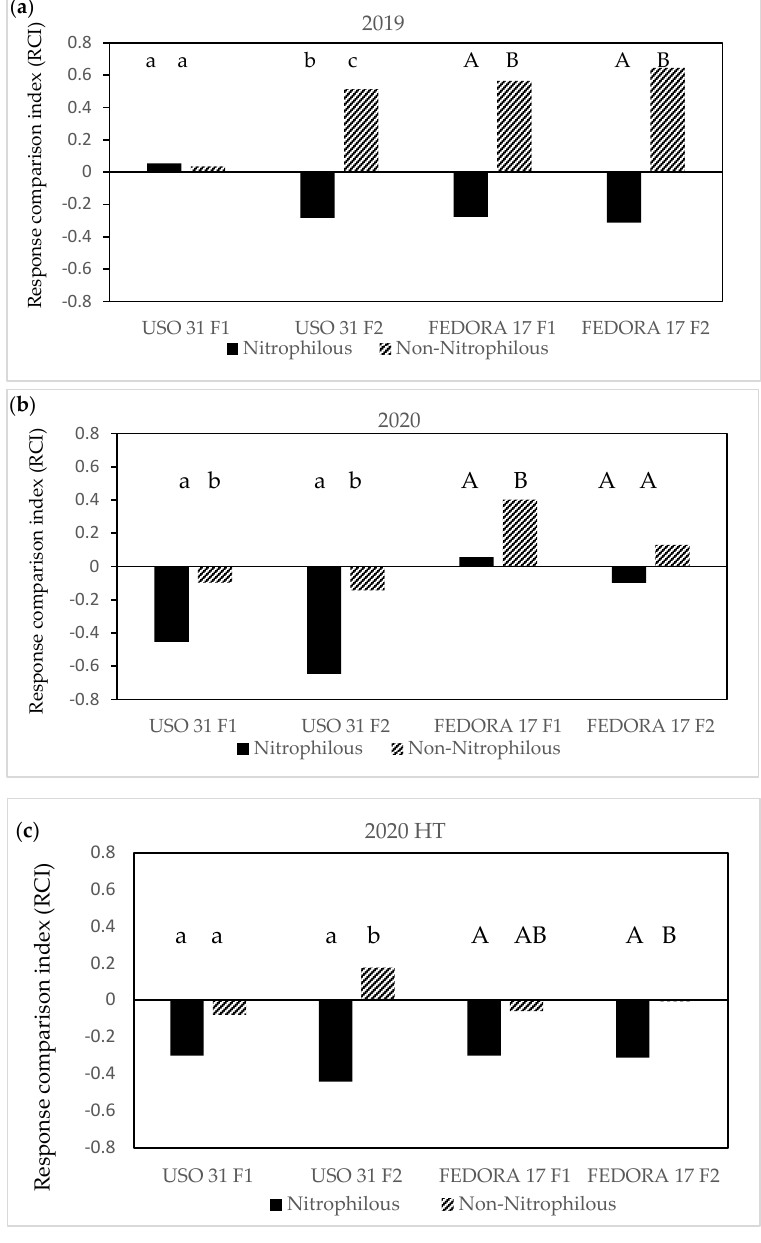
Figure 7. The effect of the interaction of the cultivar × fertilization × weed management on the response comparison index (RCI) in hemp crops during the 2019 growing season ( a ) and during the 2020 growing season ( b , c ). Values without a common letter are statistically significant according to LSD (0.05).